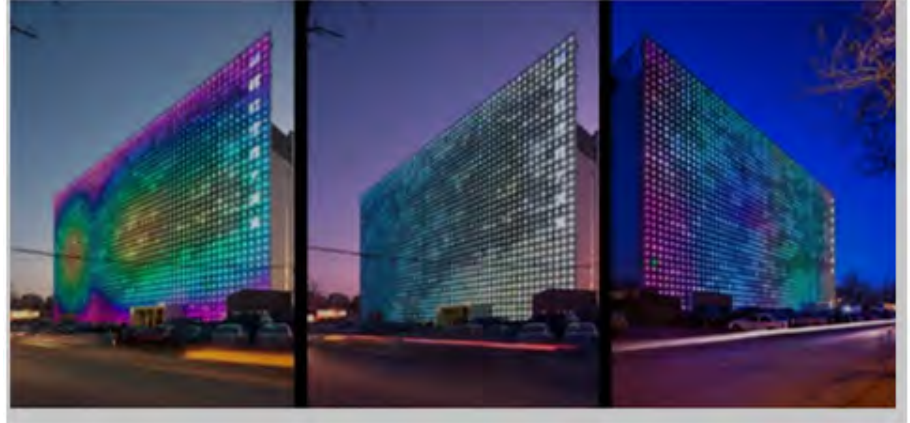
Figure 5. GreenPix; Day and